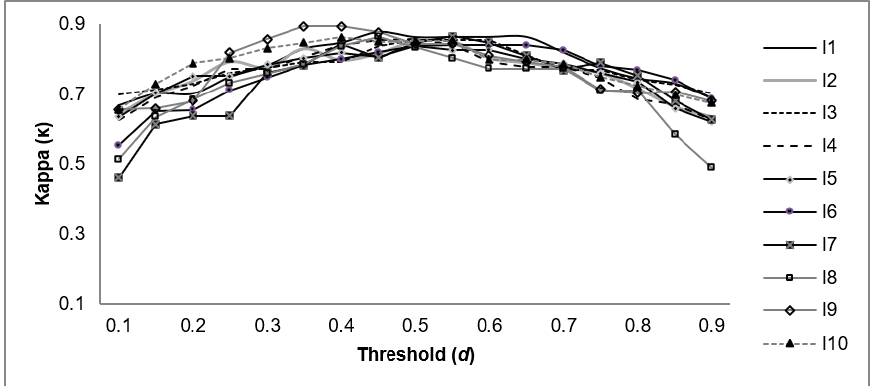
Figure 7. κ values to estimate threshold interval for generating the shoreline margin. The curves show that values of d larger than 0.7 and lower than 0.3 produced more erratic curves indicating low κ values. Threshold interval [0.3, 0.7] generally provides high κ values. Similar curves were obtained when estimated the κ for all images ( I 1 up to I 10